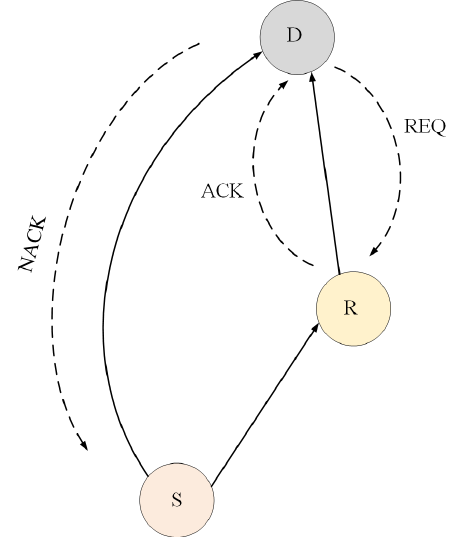
Figure 6. ACK, NACK, and REQ